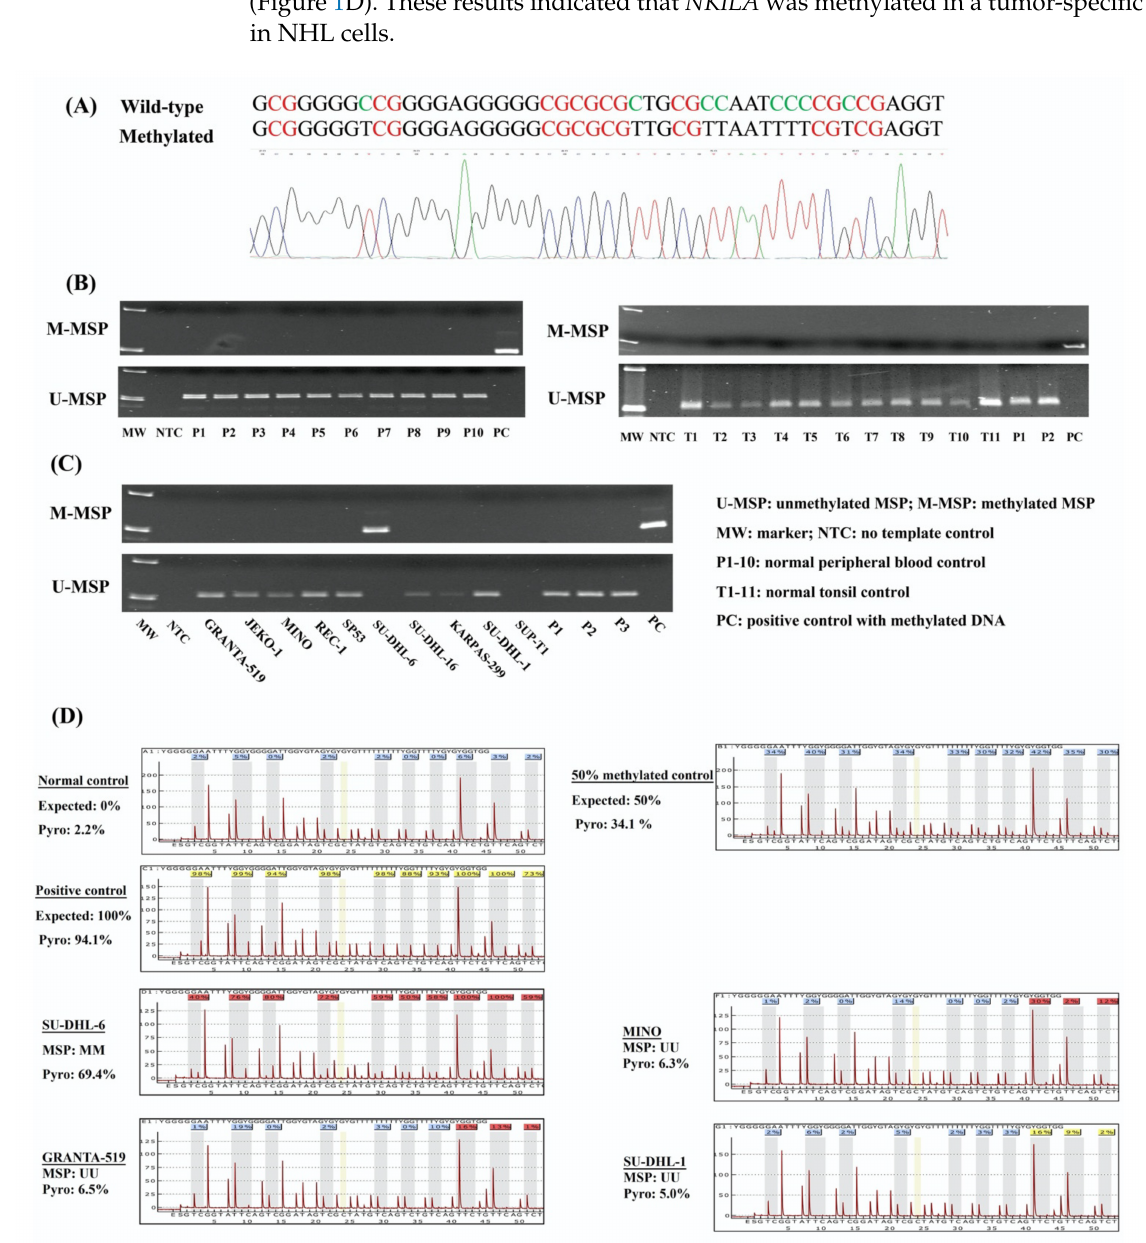
Figure 1. Methylation of NKILA in normal controls and NHL cell lines. ( A ) Direct sequencing of M-MSP products from a positive control with methylated DNA. ( B ) M- and U-MSP demonstrate that NKILA is unmethylated in normal peripheral blood buffy coats (P1–P10) and normal tonsil tissues (T1-T11). ( C ) M- and U-MSP show that NKILA is completely methylated in SU-DHL-6 cell lines and completely unmethylated in GRANTA-519, JEKO-1, MINO, REC-1, SP-53, KARPAS-299 and SU-DHL-1 cell lines. Both M-MSP and U-MSP are absent in SUP-T1 cell lines. ( D ) Quantitative bisulfite pyrosequencing analysis show the mean methylation percentage of 10 neighboring CpG dinucleotides overlapping with MSP amplicon in 0%, 50% and 100% methylation control, and NHL cell